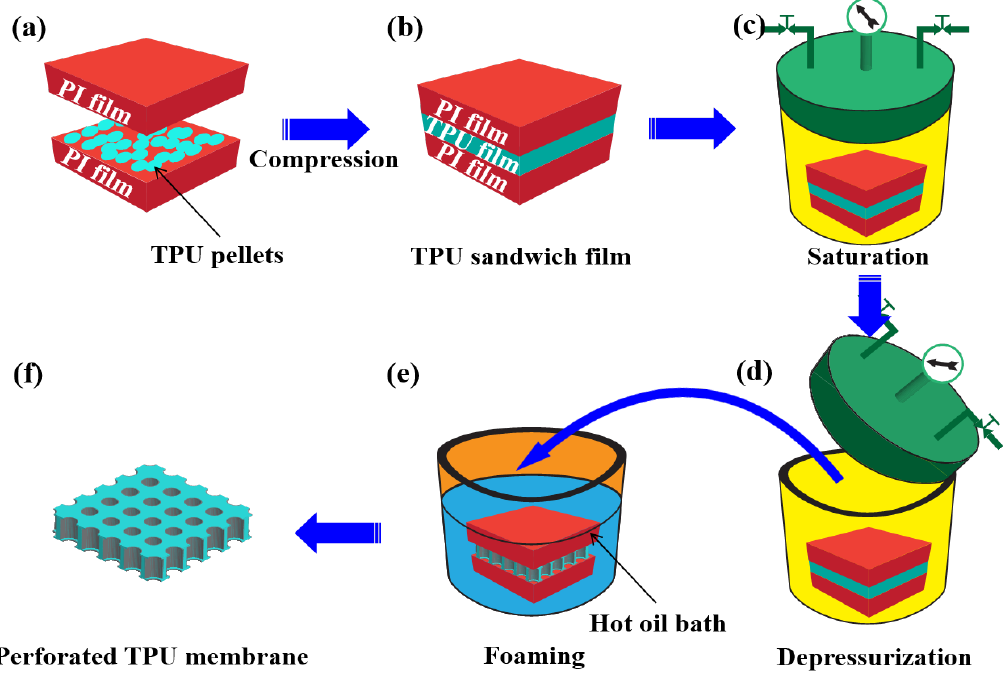
Figure 2. Schematic for preparation of TPU perforated membrane.